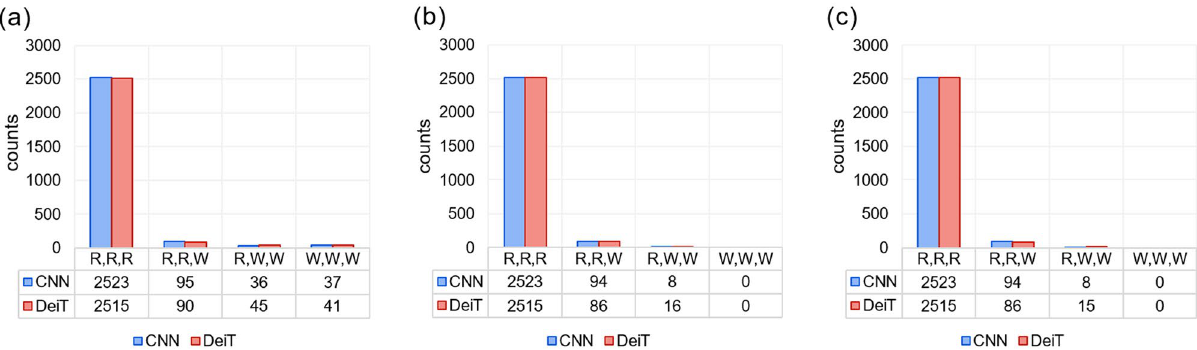
Figure 2. Comparison between three-model ensemble models based on CNNs and on DeiTs on the ZooLake test set. The bar heights indicate how often each combination (RRR, RRW, RWW, WWW) appeared. RRR indicates that all the models gave the right answer, RRW means that one model gave a wrong answer, and so on. The numbers below each bar indicate explicitly the height of the bar. On panel ( a ) we consider the whole test set, on panel ( b ) we only consider the examples which were correctly classified by the arithmetic ensemble average, and on panel ( c ) those correctly classified through geometric ensemble